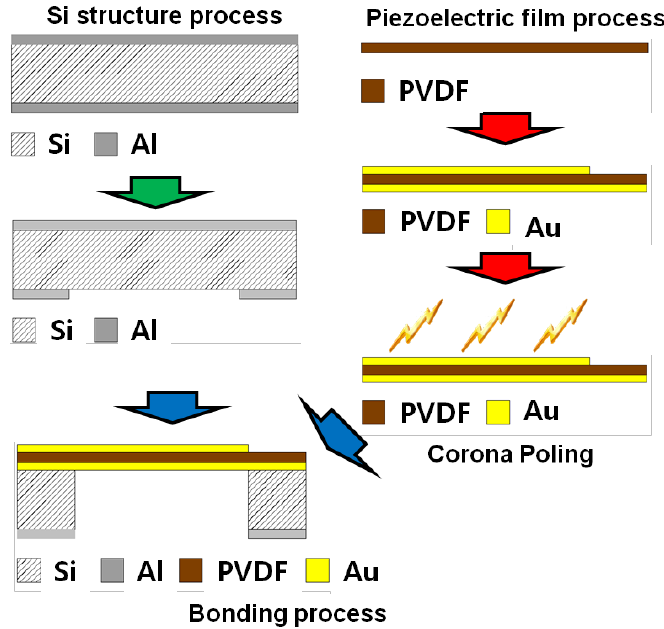
Figure 4. Schematic of the McPAS fabrication process.